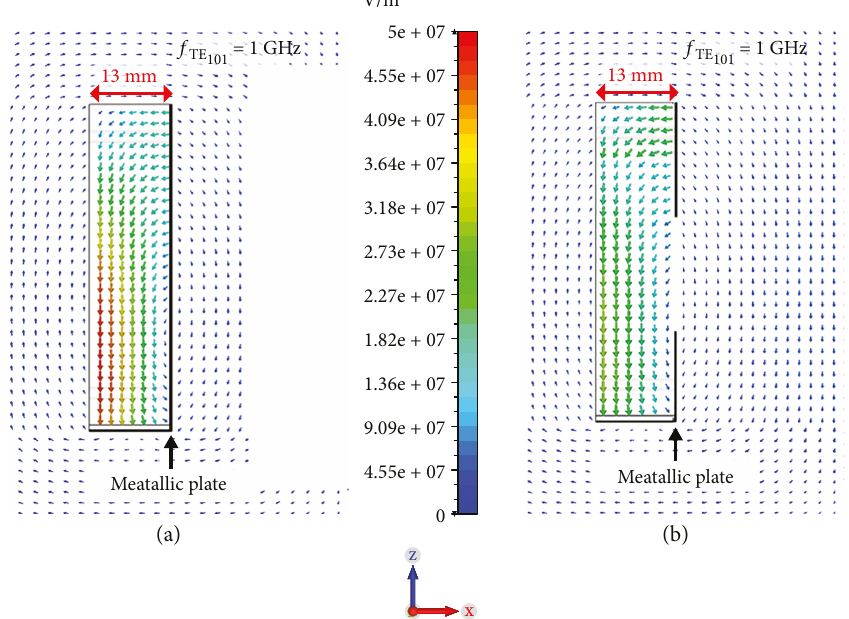
Figure 4: E- fi elds on the y = 11 mm plane of a DRA placed on a FR4 substrate coated by copper, with a metallic plate at x partial metallic plate at x max